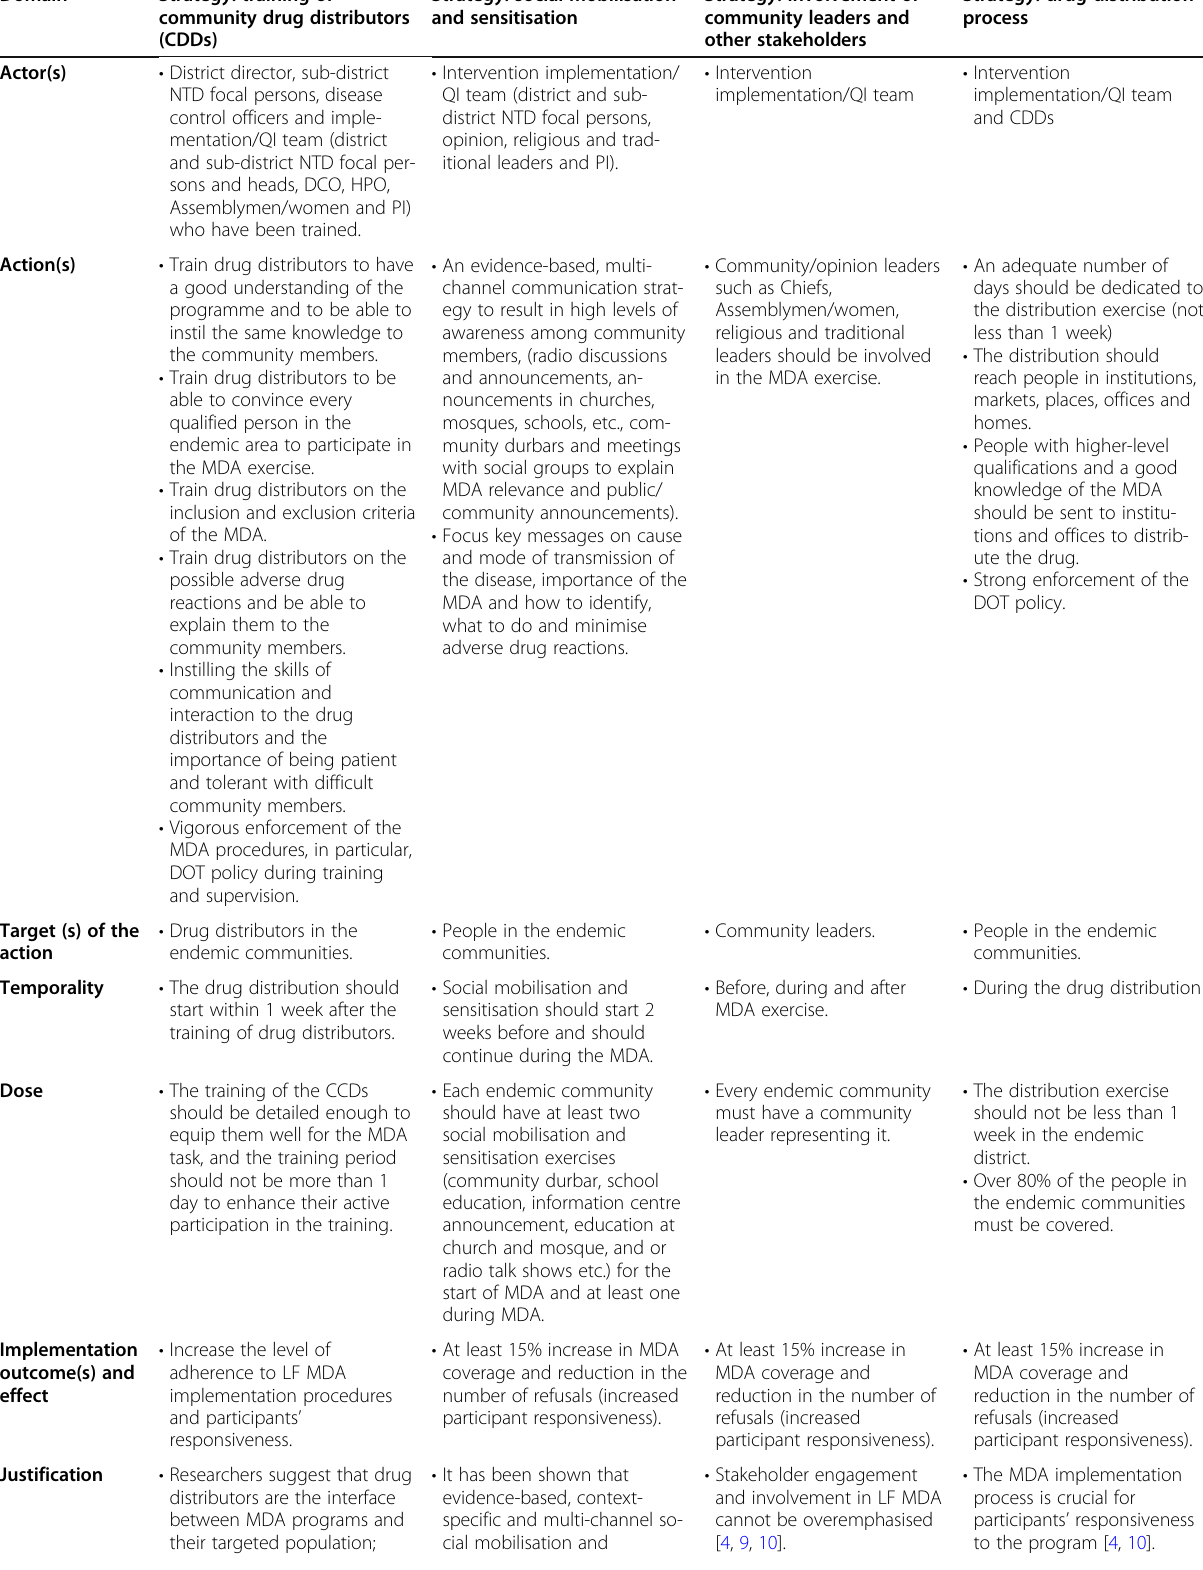
Table 1 Description of components of the context-specific evidence-based quality improvement intervention